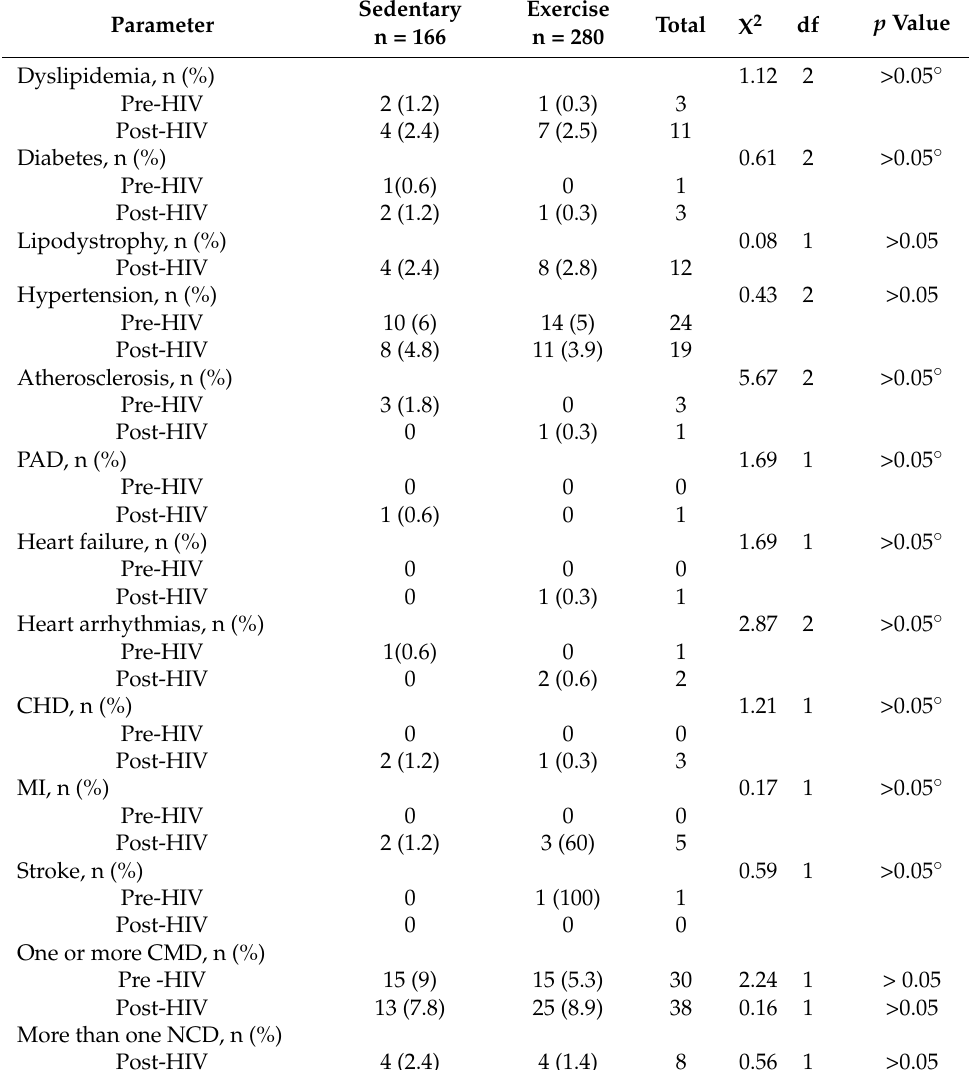
Table 3. Cardiovascular diseases after the HIV